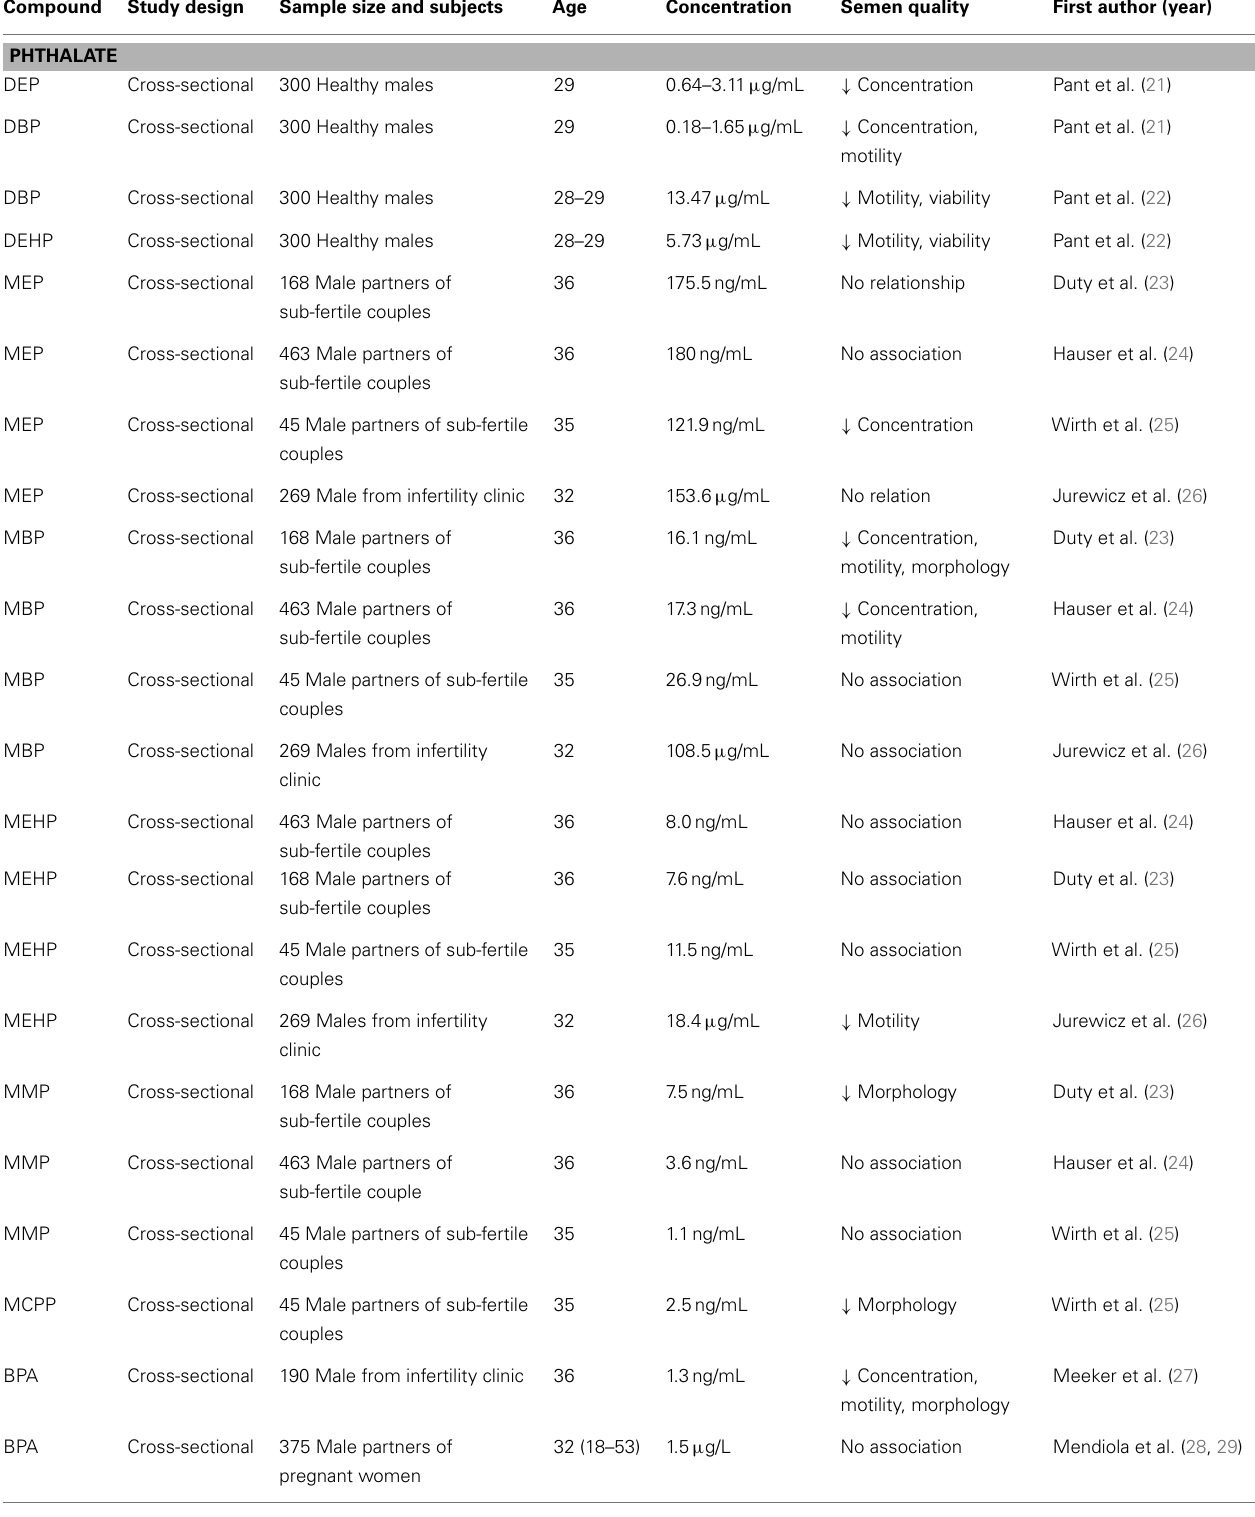
Table 1 | Epidemiological studies on semen quality and endocrine disruptors including phthalates, BPA, PCB, and DDT/DDE